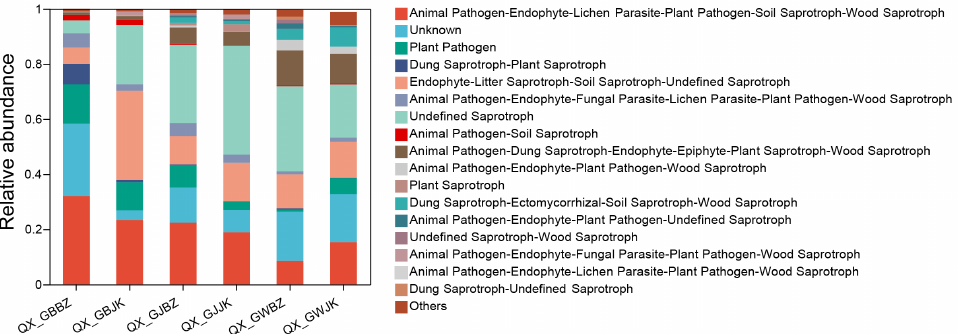
Figure 8. Prediction of the functional composition of the fungal community. Note: The abscissas from left to right represent rhizoplane diseased plant, rhizoplane healthy plant, rhizosphere diseased plant, rhizosphere healthy plant, root zone diseased plant, and root zone healthy plant. QX_GBBZ denotes the rhizoplane diseased plants, QX_GBJK denotes the rhizoplane healthy plants, QX_GJBZ denotes the rhizosphere diseased plants, QX_GJJK denotes the rhizosphere healthy plants, QX_GWBZ denotes the root zone diseased plants, and QX_GWJK denotes the root zone healthy plants.